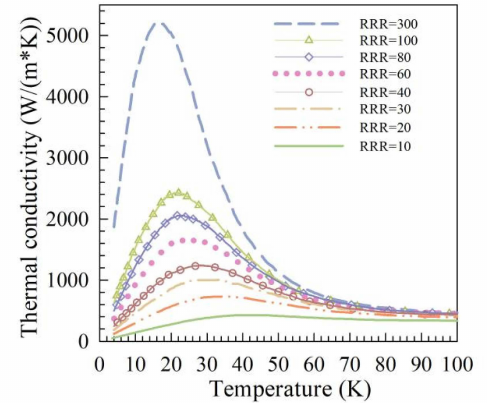
Figure 8. Temperature-dependent thermal conductivity of copper with different